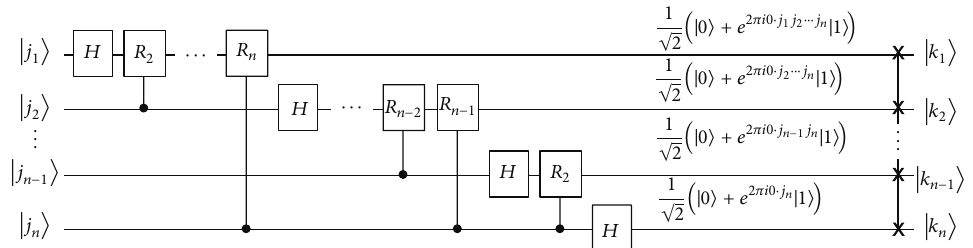
Figure 1: Quantum circuit model for n -qubit QFT.